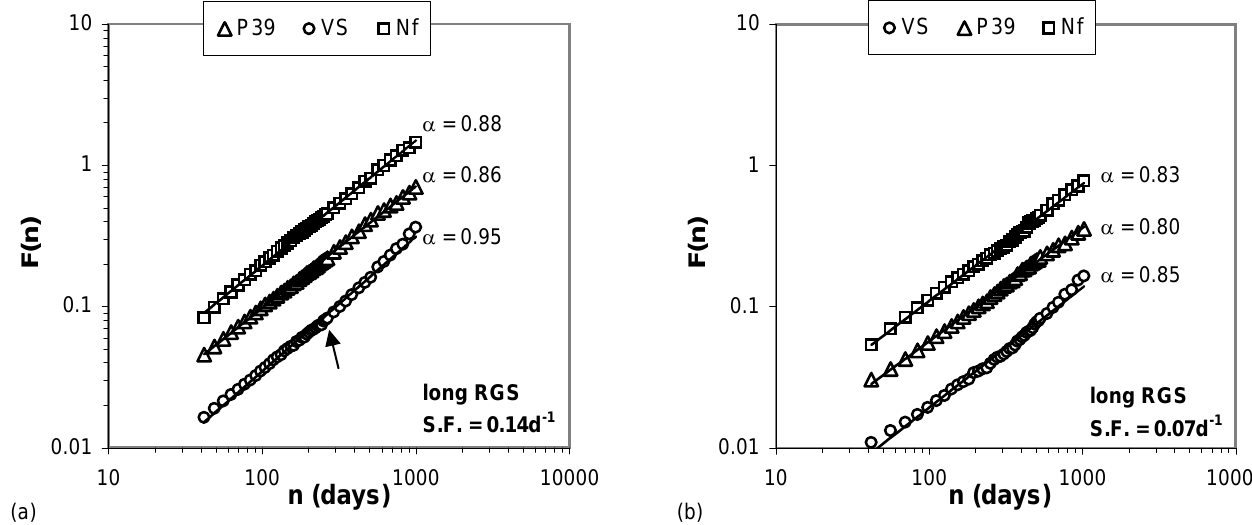
Fig. 9. Log-log plot of the fluctuation function F(n) vs. time scale n , for the RGS from Nf, VS and P39 sites. The F(n) functions of the